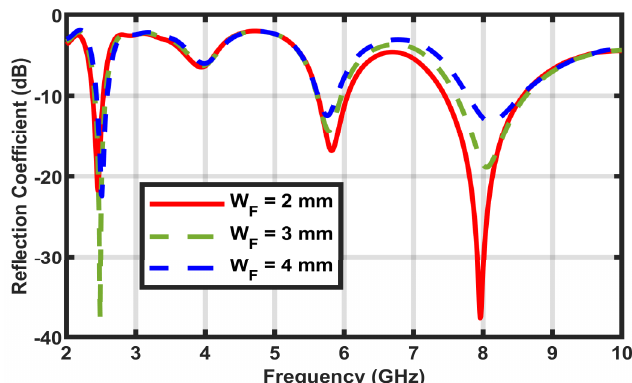
Figure 8. Effect of varying the width of the feed line on the reflection coefficient.